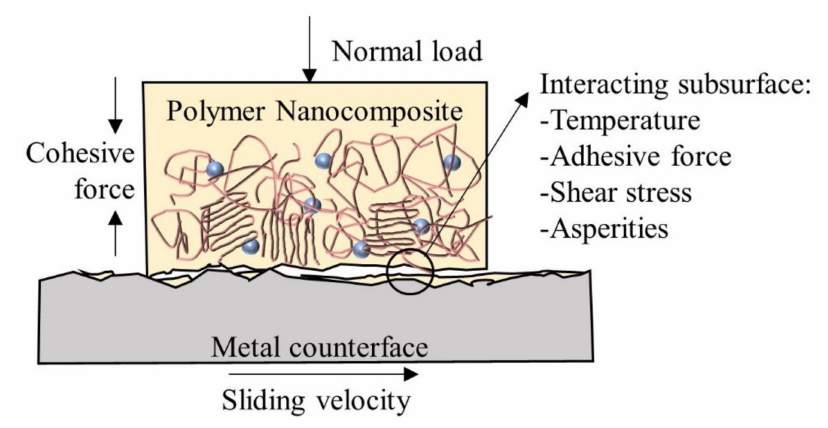
Figure 2. Parameters that have a strong influence on transfer film